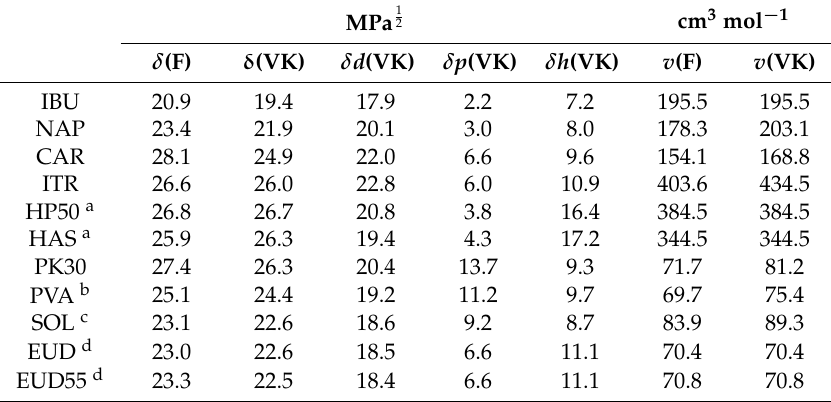
Table 3. Calculated three-dimensional solubility parameters ( δ ) and molar volume ( v ) for selected drugs and polymers according to Fedors (F) and van Krevelen (VK)